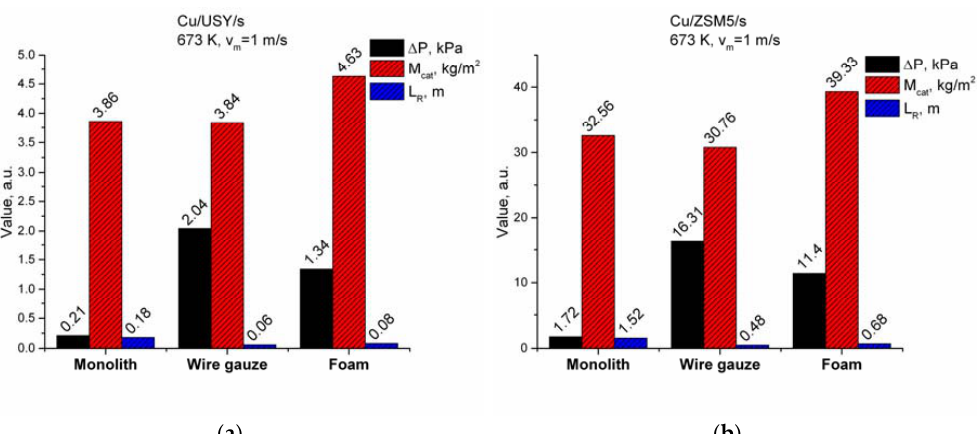
Figure 3. Comparison of reactor supports for an arbitrary assumed final conversion of X = 0.9: pressure drop in reactor ( ∆ P), reactor length (L R ), catalyst mass per square meter of reactor cross-section (M cat ); superficial gas velocity 1 m/s, inlet gas temperature 673 K, NO concentration: 2500 ppm; ( a ) Cu/USY/s; ( b ) Cu/ZSM-5/s.